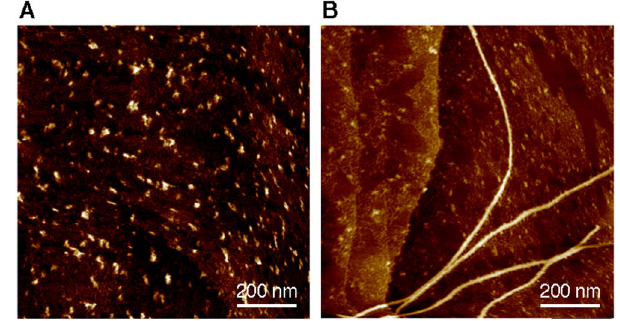
Figure 4. AFM images of two-component 2 / 6 self-assembly. AFM images (HOPG substrate) of ( A ) metastable two-component 2 / 6 J aggregate and ( B ) mixture of H aggregate of 6 and J aggregate of 2 after time-dependent